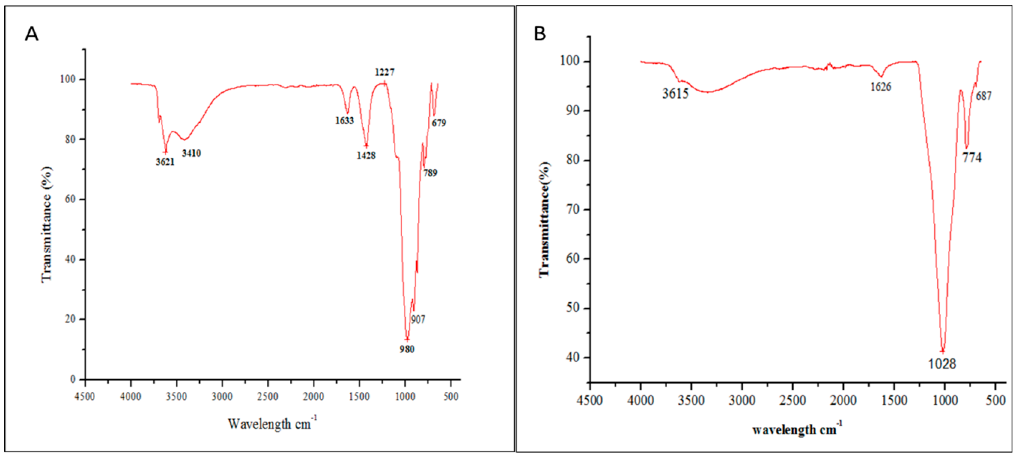
Figure 7. FTIR spectra of ( A ) raw clay RC and ( B ) acid activated clay AC with HCl 3 N for 1 h.